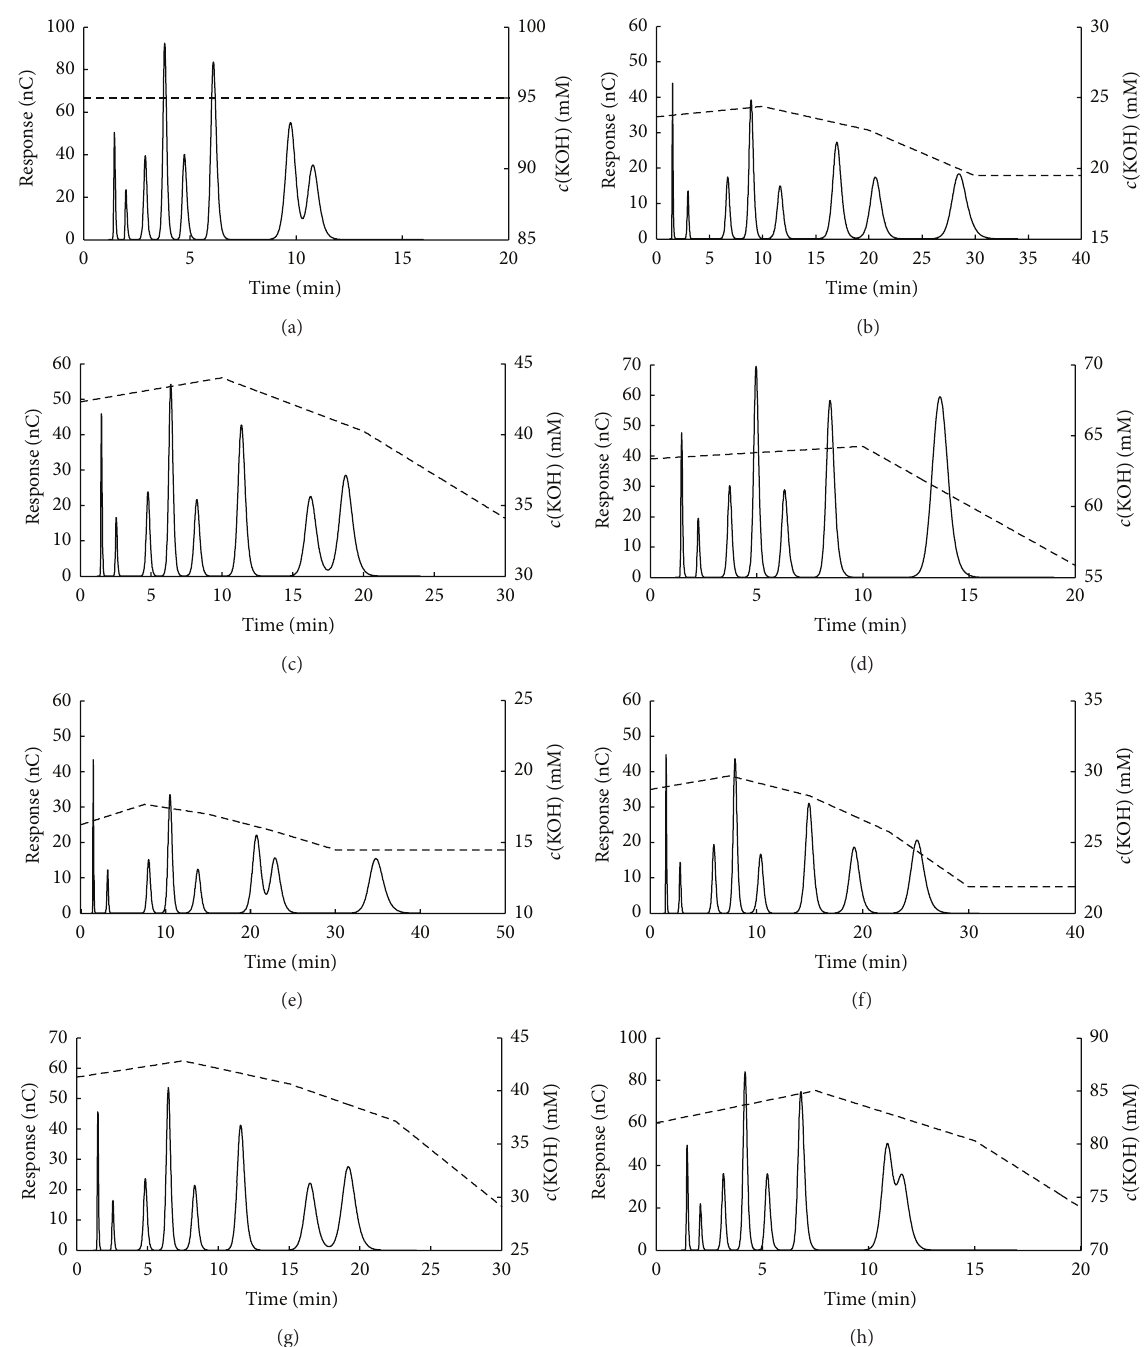
Figure 3: Searching for the appropriate number of simplex factors ( 𝑁 𝐹 ) and concentration interval ( Δ𝑐 ). The above chromatograms were obtained for (a) 𝑁 𝐹 = 2 and 3 for all Δ𝑐 , 𝑁 𝐹 = 4 and Δ𝑐 = 30 , 45, and 90 mM KOH, 𝑁 𝐹 = 5 and Δ𝑐 = 45 and 90 mM KOH, (b) 𝑁 𝐹 = 4 and = 4 and Δ𝑐 = 10 mM KOH, (d) 𝑁 Δ𝑐 = 5 mM KOH, (c) 𝑁 𝐹 = 5 and Δ𝑐 = 15 mM KOH, and (h) 𝑁 Δ𝑐 = 10 mM KOH, (g) 𝑁 𝐹